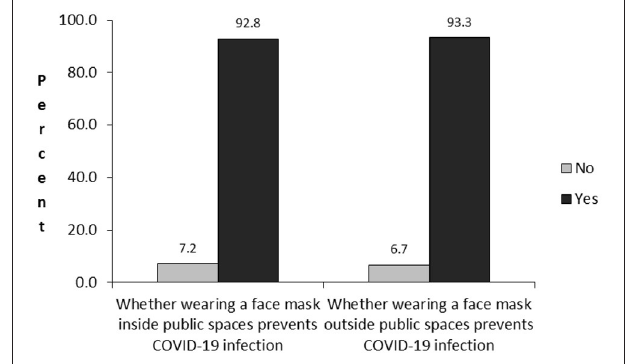
FIGURE 1 | Belief about face mask efficacy.